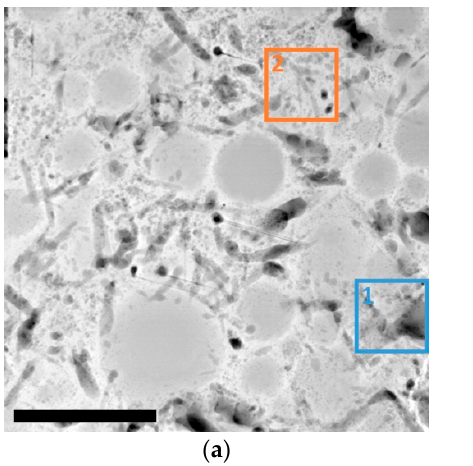
Figure 4. Sections of HAADF-STEM images after increasing durations of electron irradiation showing both shrinking and growing structural changes. From left to right: after 6 s; 30 s; 1 min; 2 min; 5 min; 10 min. Scale bar is 200 nm.